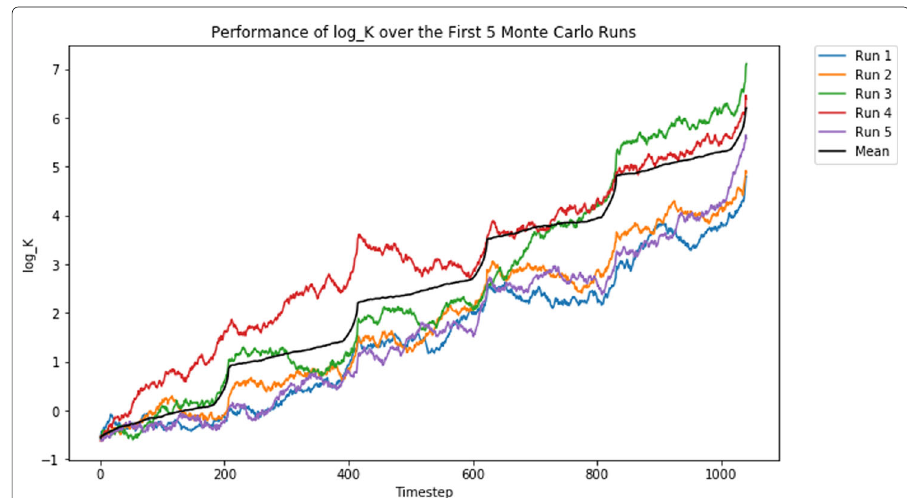
Fig. 4 Token prices over 1,040 weeks; 5 realizations under step decay block reward schedule on log scale